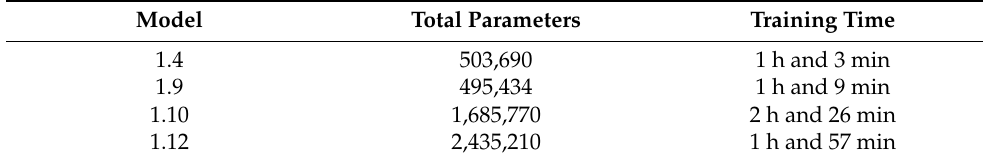
Table 4. Model training performance.